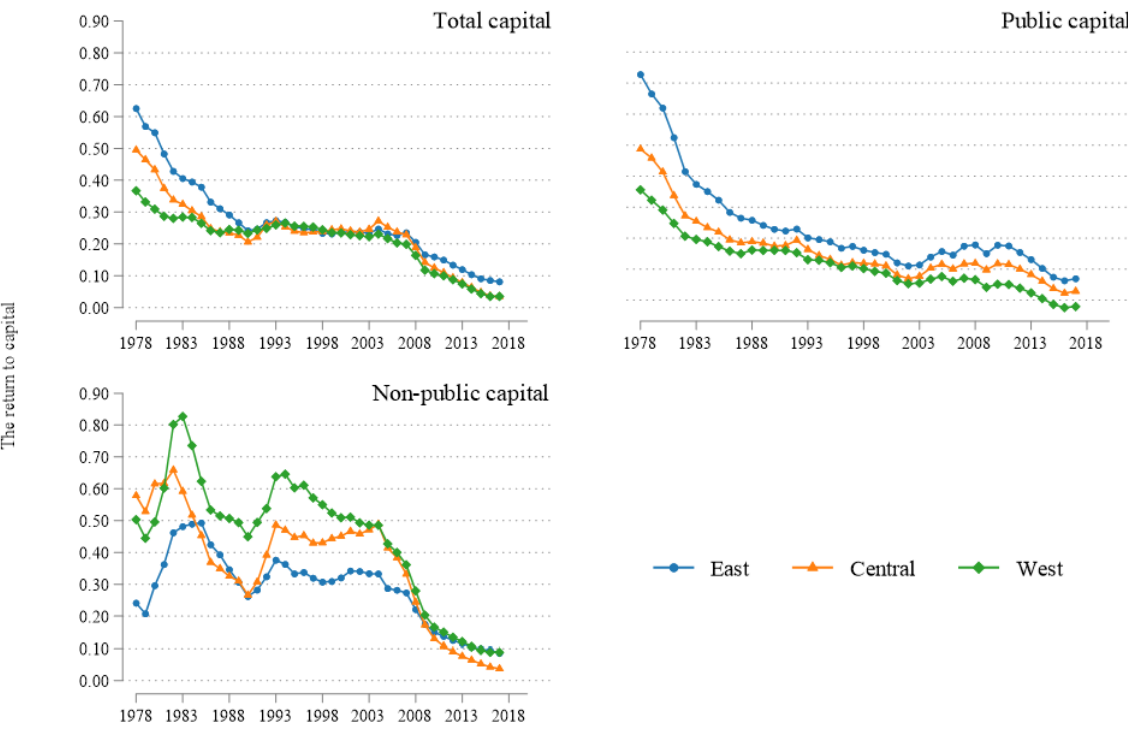
Figure 11. The return to different kinds of capital.